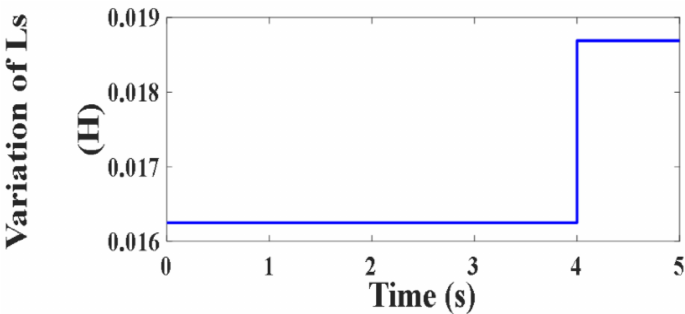
Figure 90. Variation of L s (H).